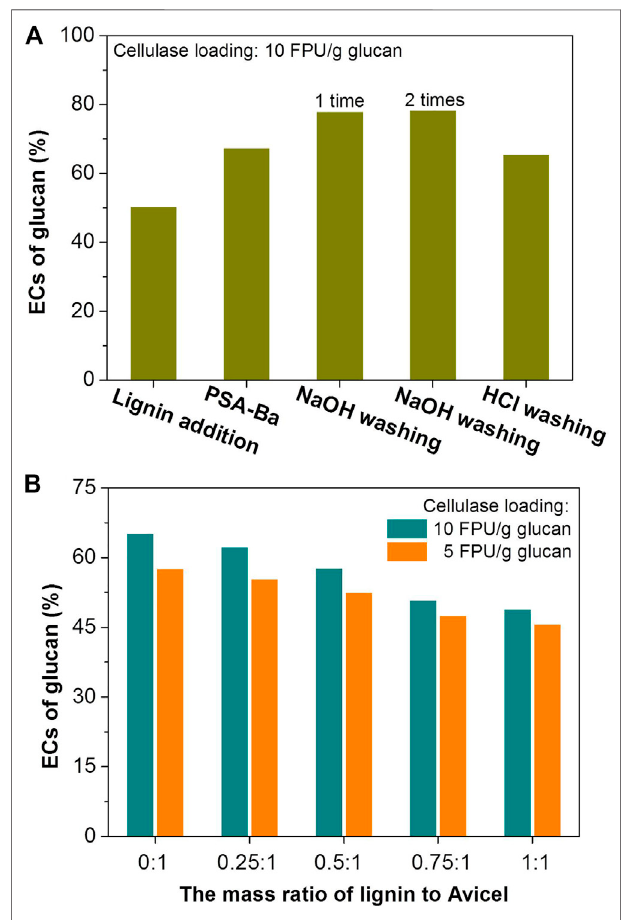
FIGURE 1 | Effects of PSA lignin addition and washing treatment on the ECs of glucan in (A) PSA-Ba substrate and (B) pure cellulose (Avicel). The massratioofaddedPSAlignintoPSA-Basubstrate(o.d.)shownin Figure1A was 1:1. The β -glucosidase loadings are 7.5 and 15 CBU/g glucan for the enzymatic hydrolysis with cellulase loadings of 5 and 10 FPU/g glucan, respectively. The pH value of acetate buffer solution is 5.